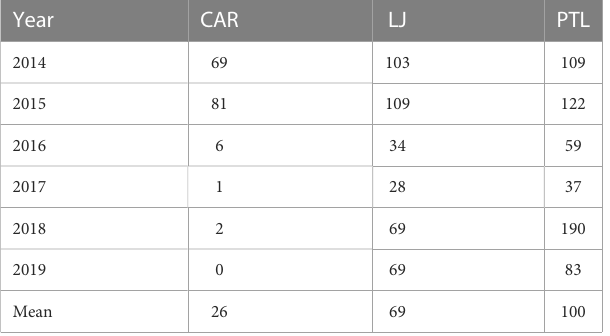
TABLE 1 Kelp persistence 2014 through 2019 for sites at Cardiff (CAR), La Jolla (LJ), and Point Loma (PTL). CAR LJ